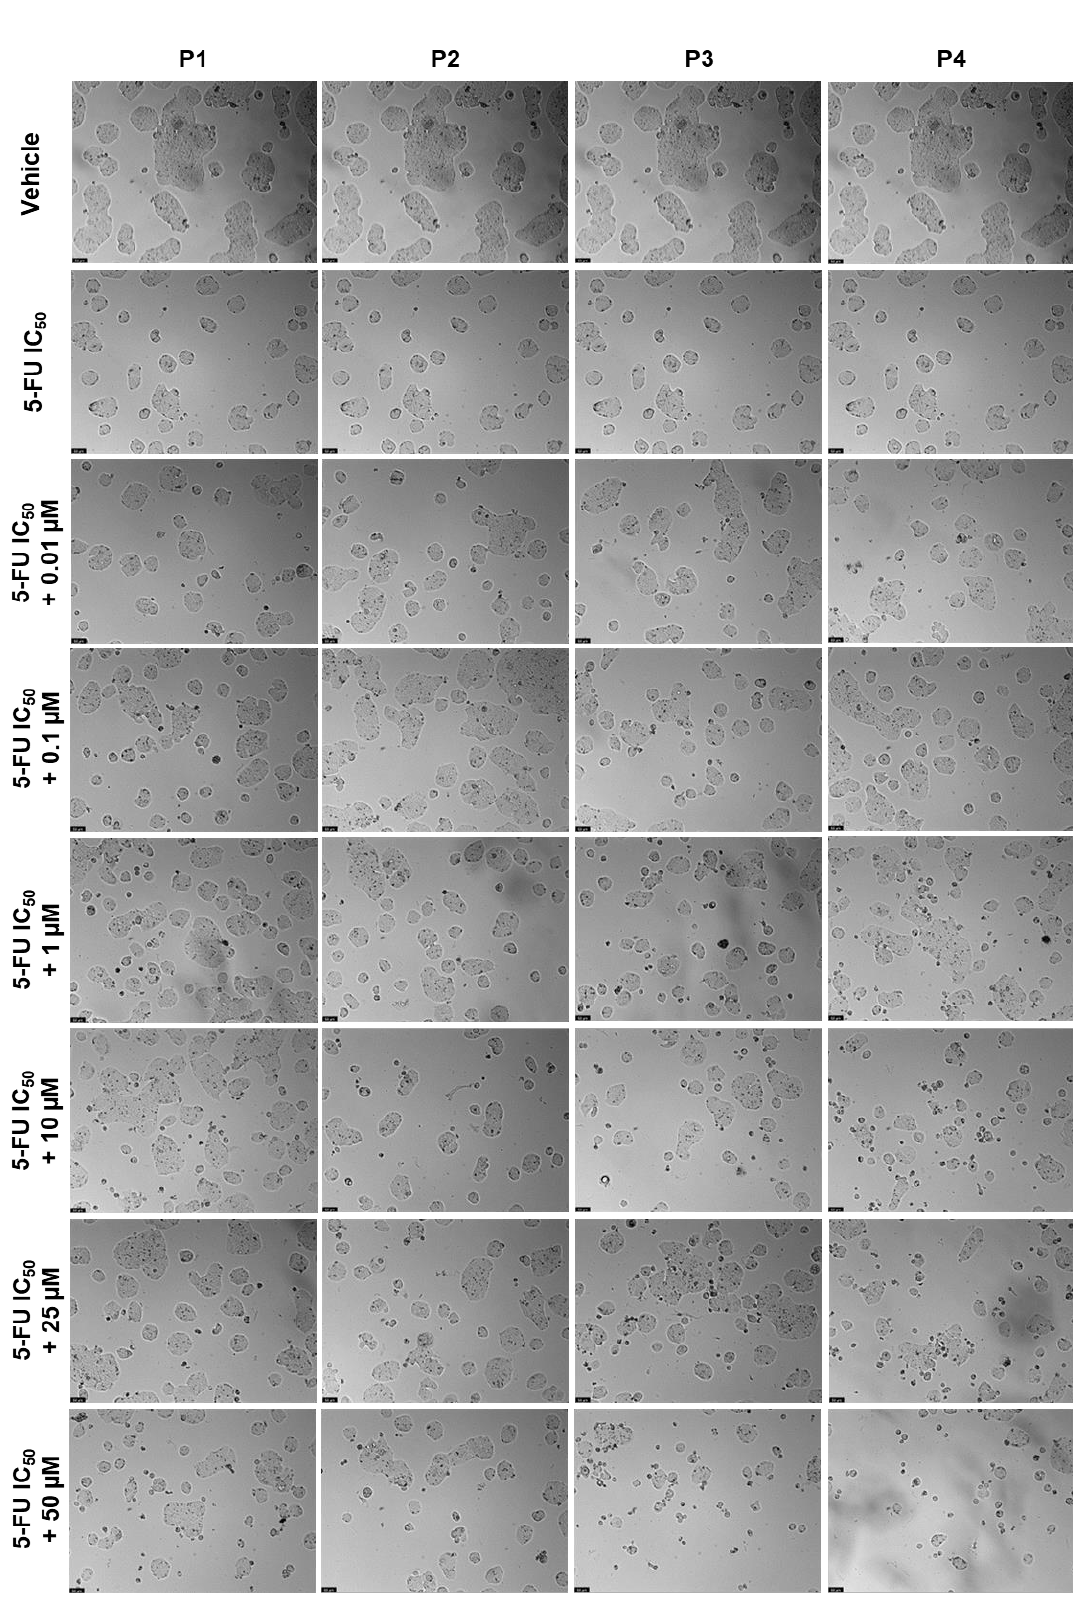
Figure 21. Morphological evaluation of HT-29 after exposure to a combination of the IC 50 of 5-FU (3 μM) with increasing concentrations of P1– P4 (0.01 – 50 μM) for 48 h. Both substances were added at the same time. Control cells were treated with the vehicle (0.01% DMSO). These images are representative of three independent experiments. Scale bar is 200 μM.